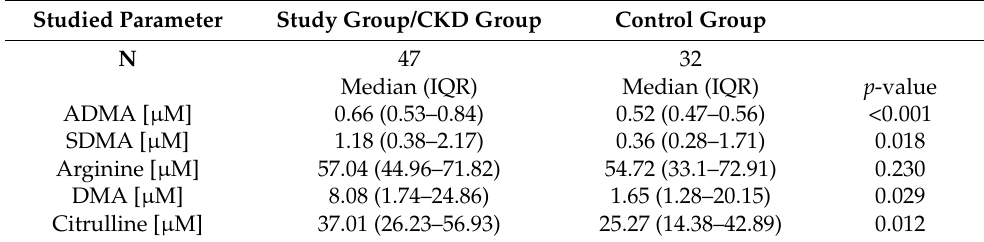
Table 2. Comparison of test results for both study and control group (N = 79, data was missing for 2 patients). A comparison of parameter results was performed using the Mann–Whitney U